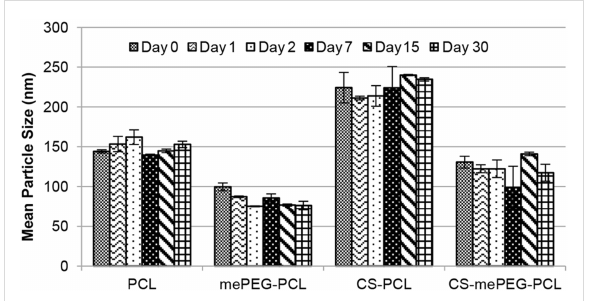
cally stable for a period of 1 month.